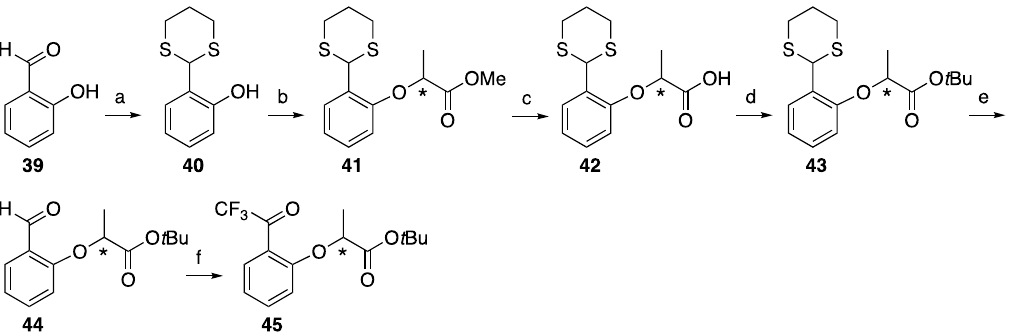
Figure 6. Synthesis of 2-trifluoroacetyl lactisole derivative. ( a ) 1,3-propanedithiol, I 2 , CH 2 Cl 2 , rt, 1 h,